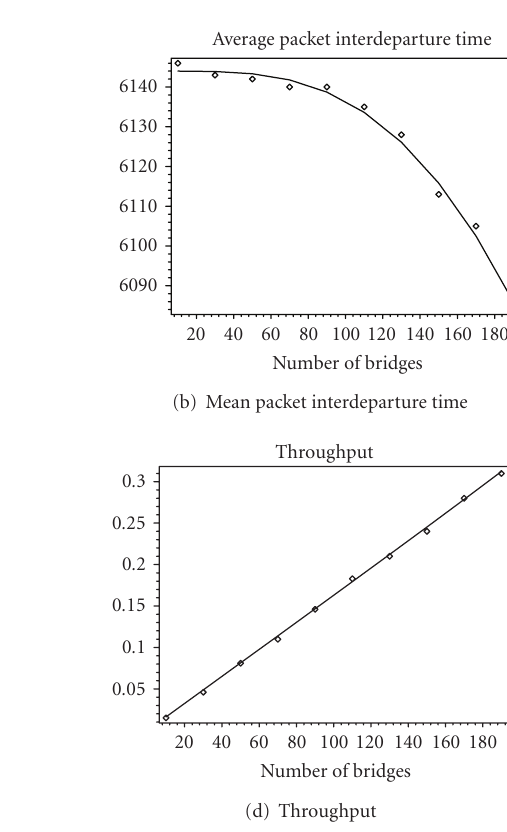
Figure 6: Mean number of packets left in the bridge’s queue after departing packet, mean packet interdeparture time, bridge o ff ered load, and throughput. Analytical results are shown as lines, and simulation results are shown as